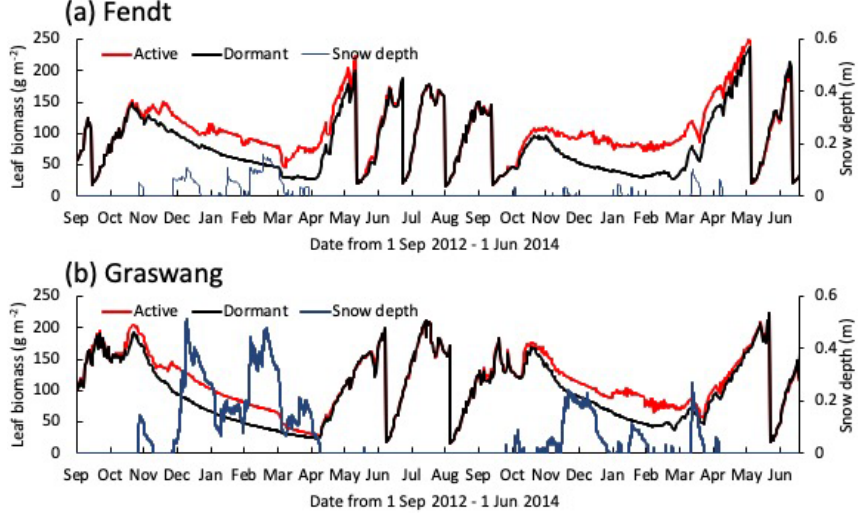
Figure 4. Time series for calculated leaf biomass and snow depth (blue lines) at (a) Fendt and (b) Graswang from 1 September 2012 until 1 June 2014, in active (red lines) and dormant cases (black